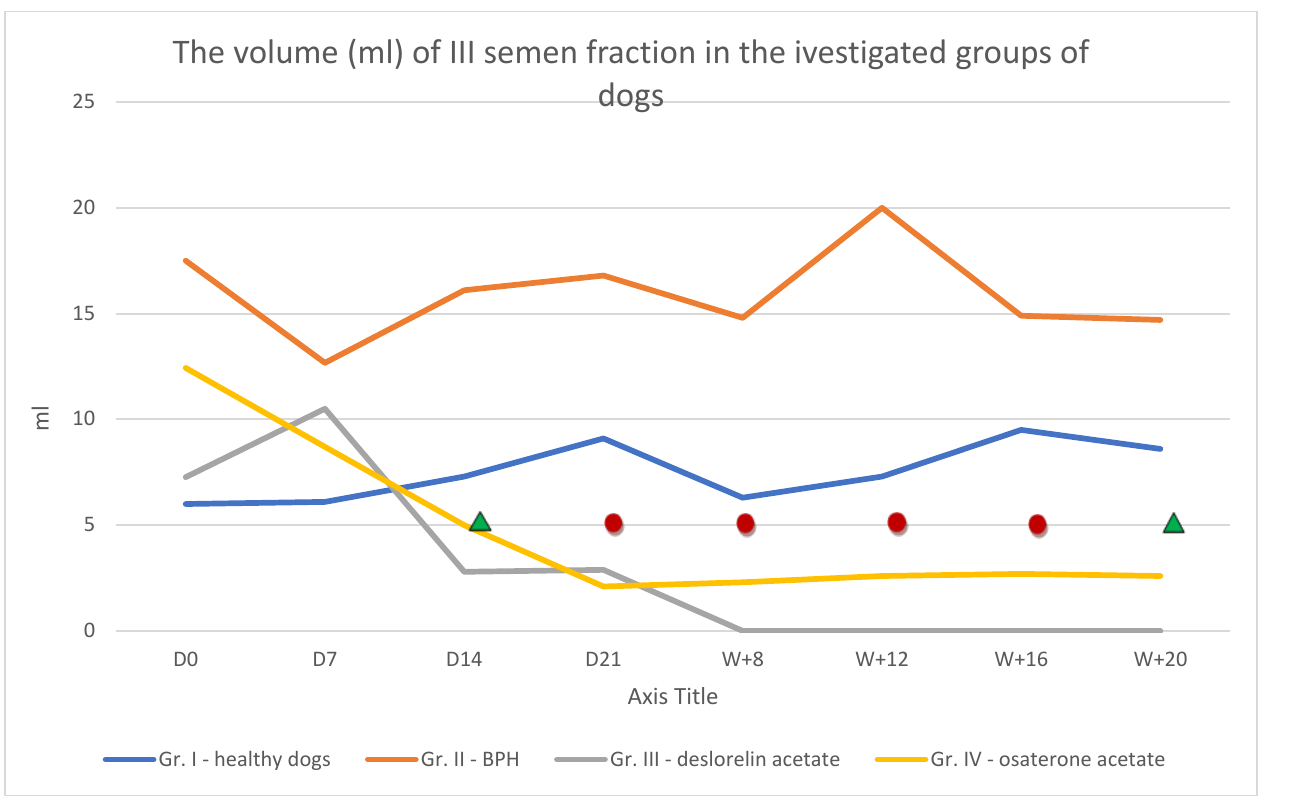
Figure 1. The volume of semen fraction III in Group I, II, III and IV of investigated dogs (mL) in subsequent examinations until week 20 n = 6; (mean; p < 0.05, p < 0.01 in relation to D0).